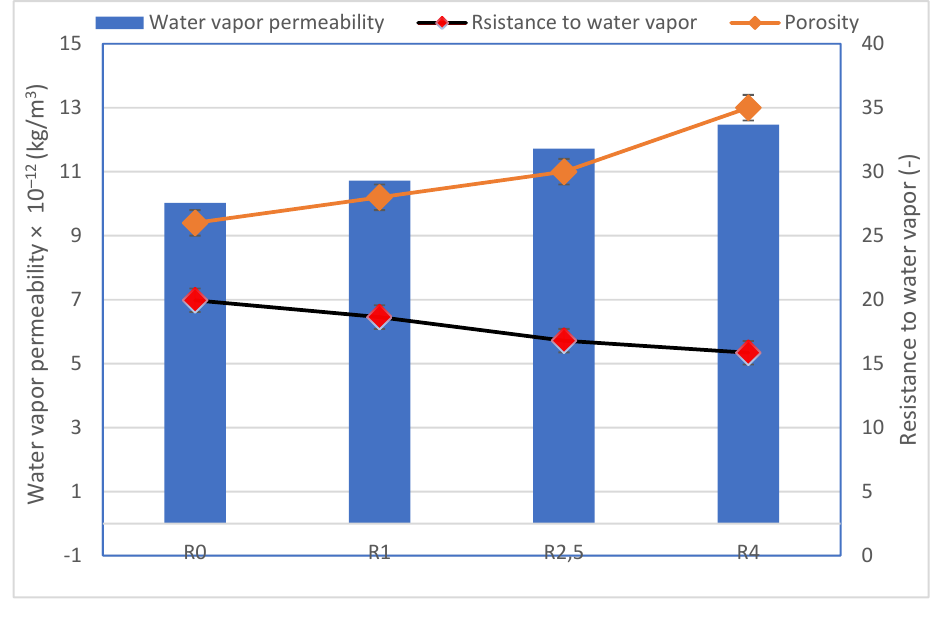
Figure 7. Water vapor permeability and resistance factors measured for all the formulation mixtures compared to cement mortar [58]. The moisture sorption isotherms at increasing RHs in ambient air at a temperature of 23 ◦ C (Figure 8) show that adding seaweed to the cob enhances the quantity of the absorbed moisture.